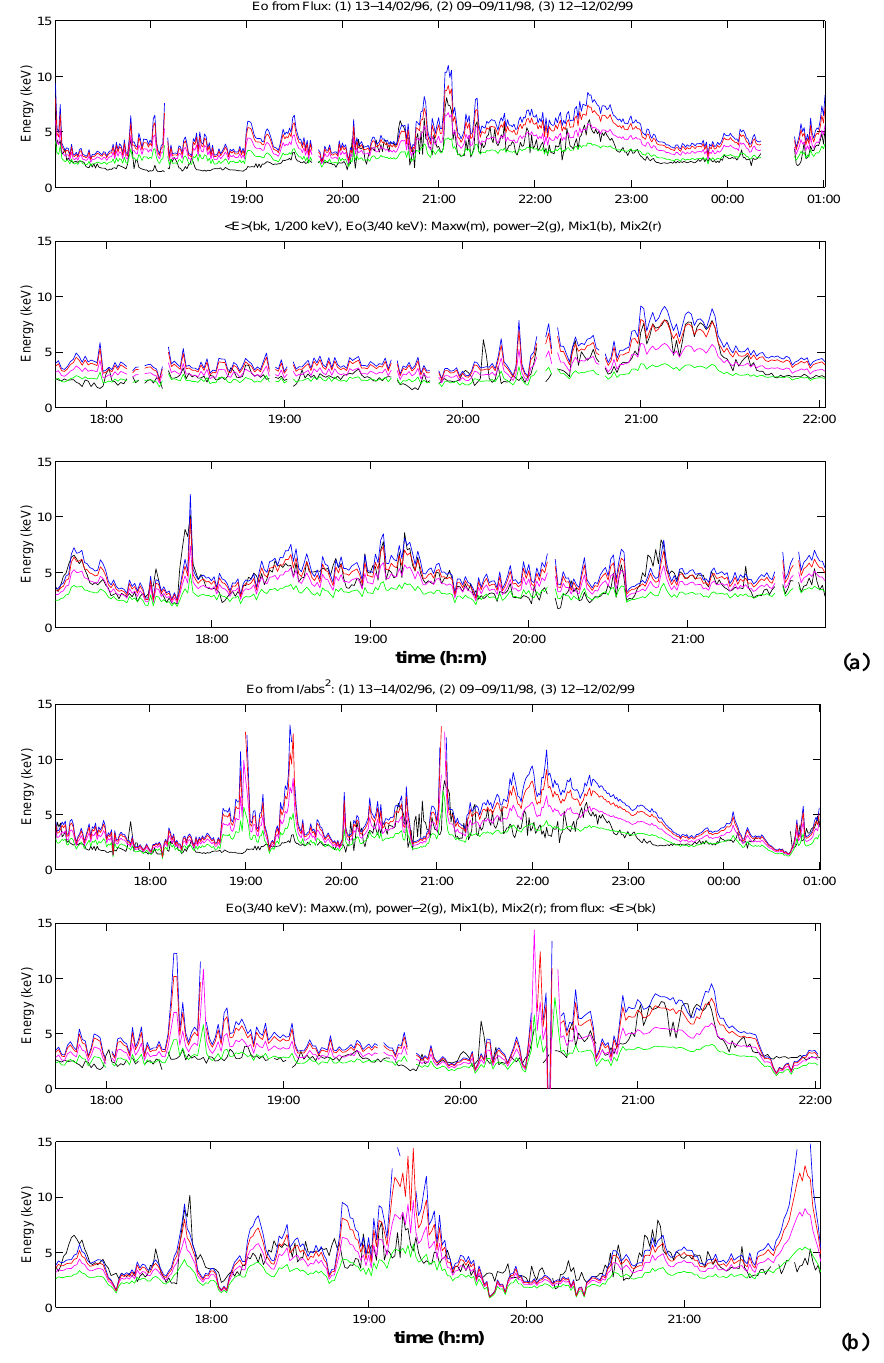
Fig. 6. (Top panel) 13–14 Feb 1996, (middle panel) 9 Nov 1998, and (bottom panel) 12 Feb 1999. In all cases, the black curve shows the same energy h E i as Fig. 5. Both Figs. 6a and b display together the Eo estimates by considering two mixed distributions, an expo- nential/Maxwellian (blue curve) and an exponential/power-2 (red curve); the magenta and green curves show Eo for, respectively, a full Maxwellian distribution and a full power-2 distribution. Figure 6a employs the ratio ( F 2 /F 1 ) at energies E 1 = 40keV and E 2 = 3keV, and Fig. 6b applies data from ratio (Int/Abs 2